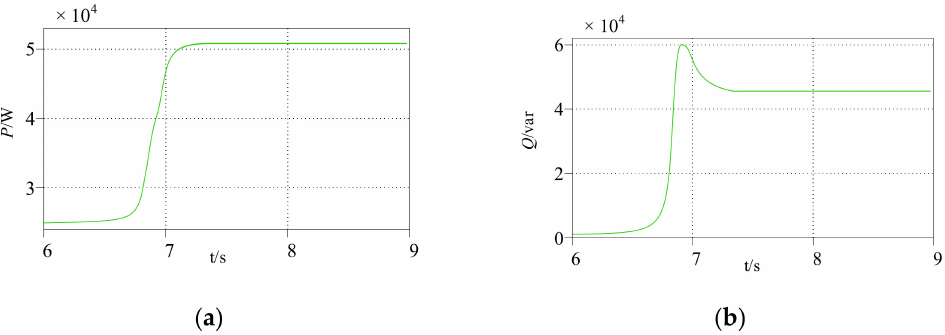
Figure 9. ( a ) Active power of a GFL converter ( P set = 25,000 W, SCR = 4.84); ( b ) reactive power of a GFL converter ( P set = 25,000 W, SCR = 4.84).